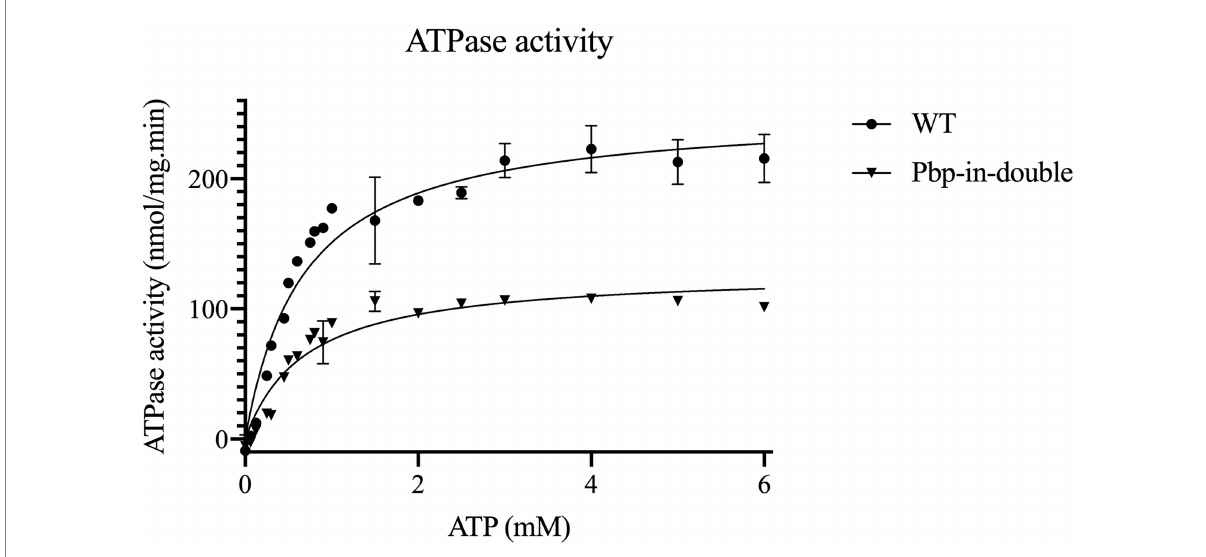
FIGURE 4 Kinetic measurements of the ATPase activity of HlyB NBD mutants, WT HlyB NBD (circle) and double-pbp-in (triangle). Data are from minimum two independent replicates, error bars were calculated by SEM.